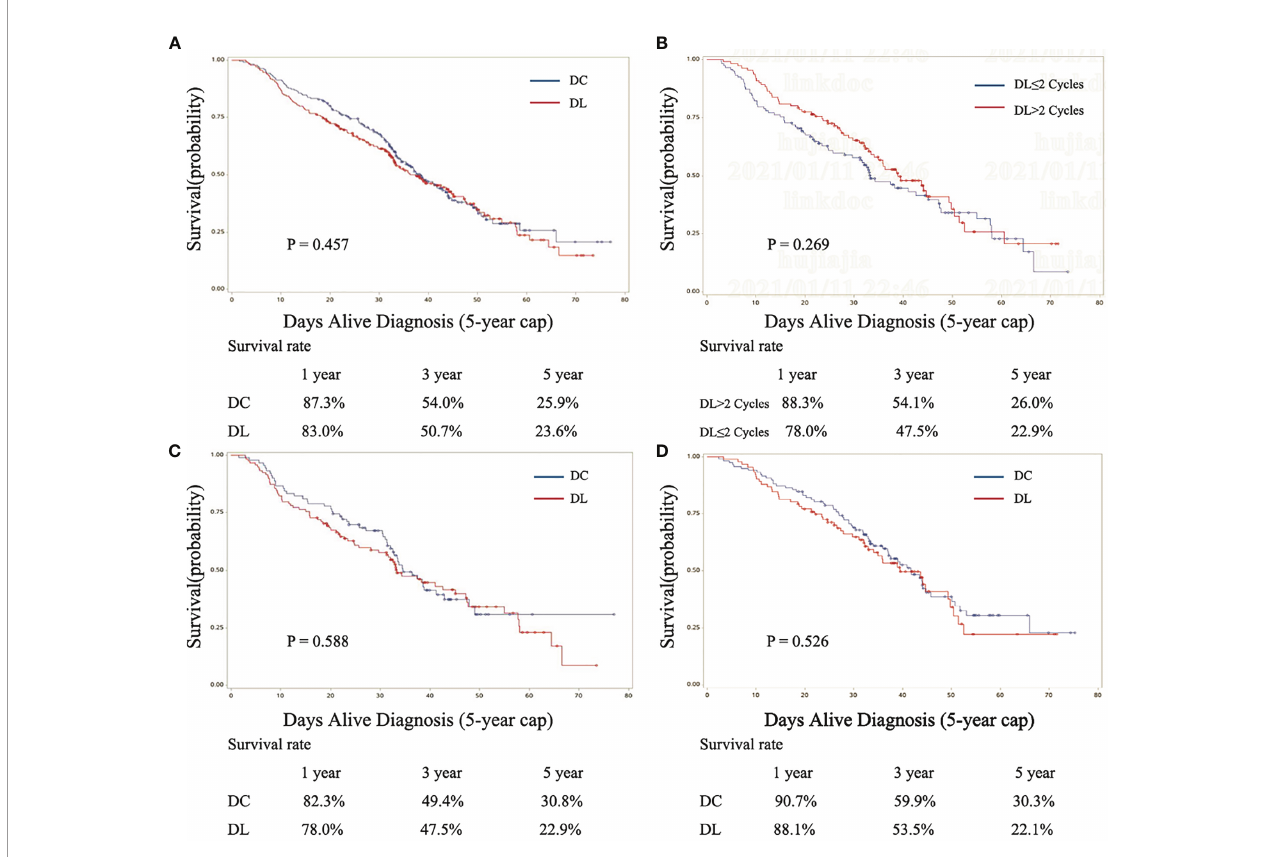
FIGURE 3 | Kaplan-Meier curves for the 3-year survival outcomes of propensity score – matched patients by regimen (DL and DC). (A) Fully matched cohort, (B) DL subgroup, (C) 1 – 2 cycles of AC group of DL and DC, and (D) 3 – 4 cycles of AC group of DL and DC. DL, docetaxel+ lobaplatin; DC, docetaxel+